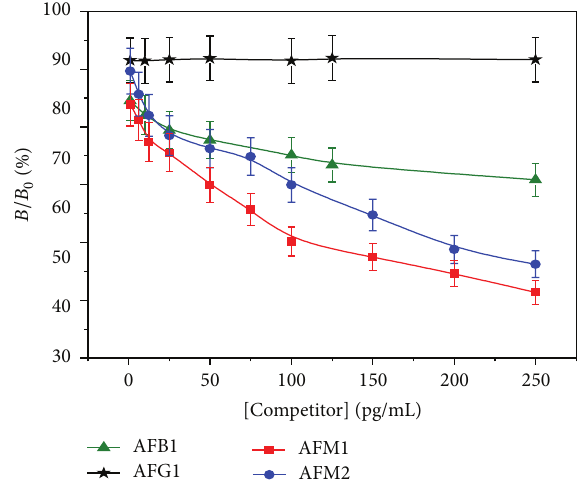
Figure 6: Fluorimetric analysis of aflatoxins at different concentra- tions carried out using 1:16000 1 ∘ mAb in CB as capture antibody, FITC labeled 2 ∘ Ab used at 1:64000 dilution; incubation time was 2 h, excitation time